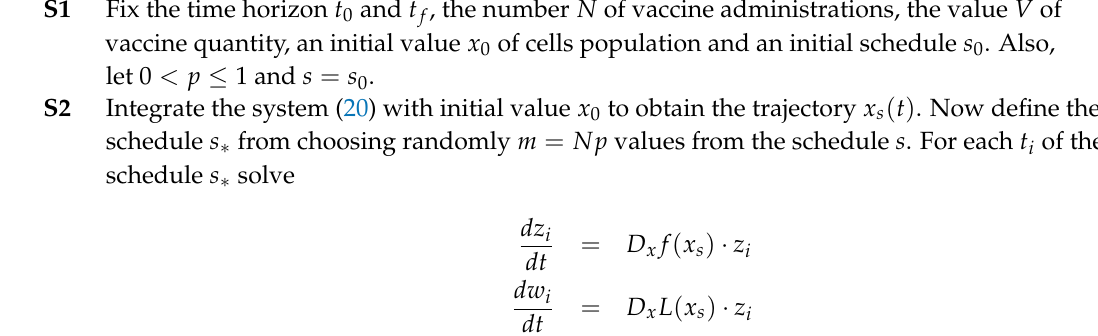
Algorithm 1: Schedule Optimization with stochastic